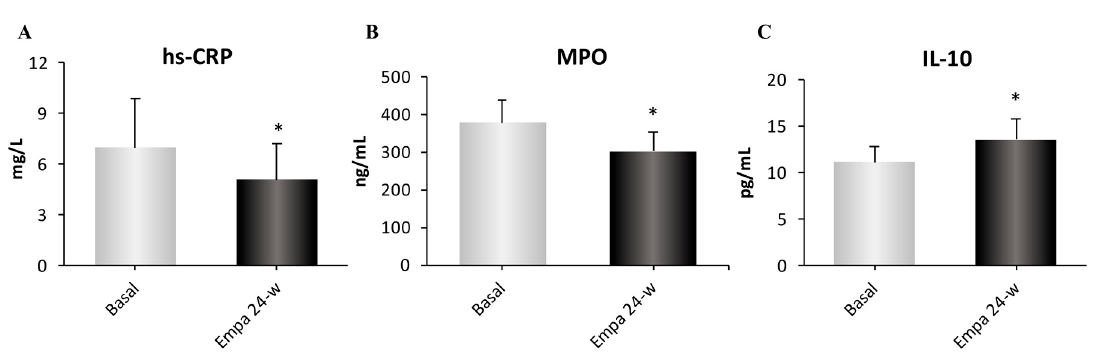
Figure 3. Assessment of inflammatory parameters; serum hs-CRP ( A ), MPO ( B ) and IL-10 ( C ) levels at baseline, 12 and 24 weeks of treatment. Abbreviations: EMPA, empagliflozin; hs-CRP, high-sensitive C-reactive protein; MPO, myeloperoxidase; IL-10, interleukin 10. * p < 0.05 compared with type 2 diabetes baseline.